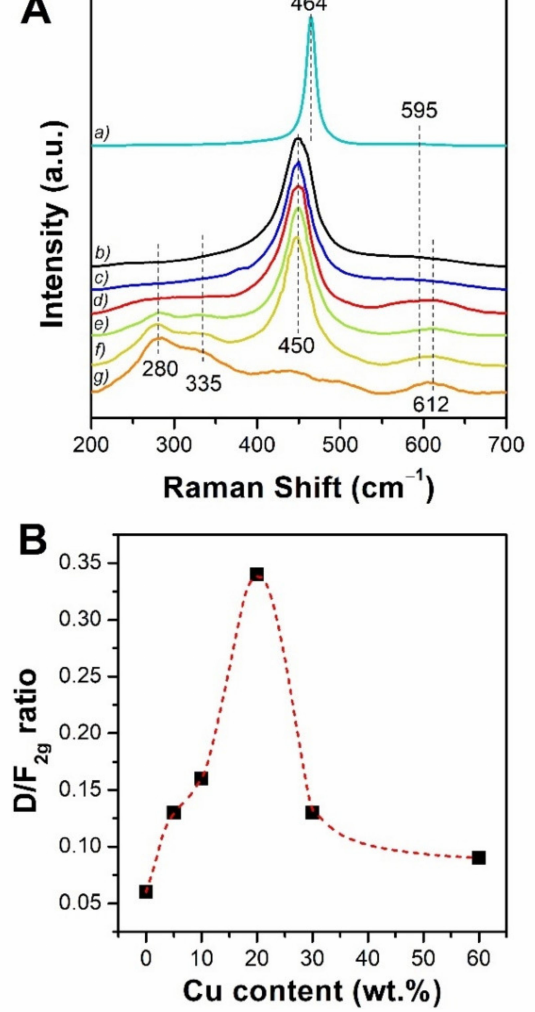
Figure 3. ( A ) Raman spectra of (a) CeO 2 , (b) 5%CuCeO x , (c) 10%CuCeO x , (d) 20%CuCeO x , (e) 30%CuCeO x , (f) 60%CuCeO x and (g) CuO collected at ambient conditions, normalized to the intensity of ceria F 2g peak. ( B ) Variation of the D/F 2g ratio as a function of the Cu